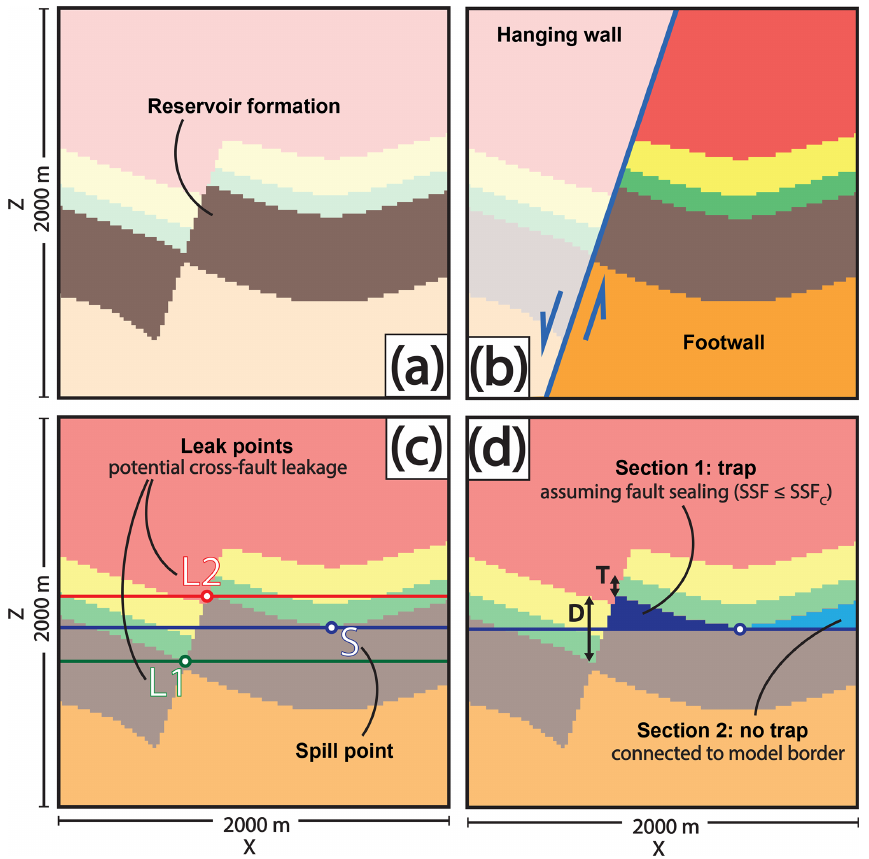
Figure 4. Illustration of the process of trap recognition in 2-D, i.e., the conditions that have to be met by a model voxel to be accepted as belonging to a valid trap. A voxel has to be labeled as part of the target reservoir formation (a) and positioned in the footwall (b) . Trap closure is defined by the seal shape and the normal fault (c) . Consequently, the maximum trap fill is defined by either the anticlinal spill point (S) or a point of leakage across the fault, depending on juxtapositions with layers underlying (L1) or overlying the seal (L2). The latter is only relevant if the critical shale smear factor is exceeded, as determined over D and T in (d) . In this example, assuming sealing of the fault due to clay smearing, the fill horizon is determined by the spill point in (d) . Subsequently, only trap section 1 is isolated from the model borders in (d) and can thus be considered a closed trap. Voxels included in this section are counted to calculate the maximum trap